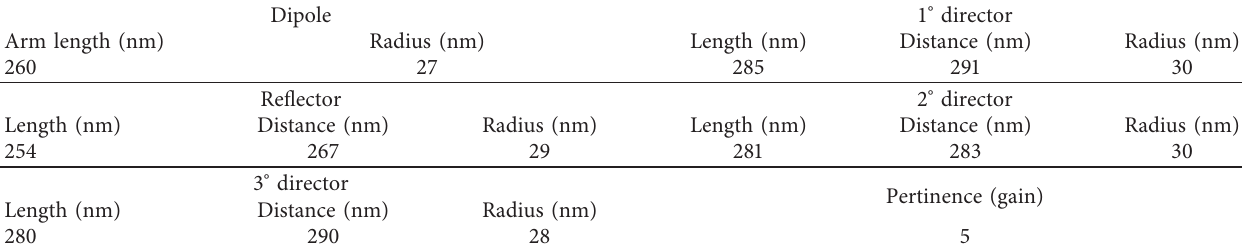
Table 4: Optimal dimensions found by the fuzzy adaptive AGPSO method for YU nanoantenna connected to a transmission line. Dipole